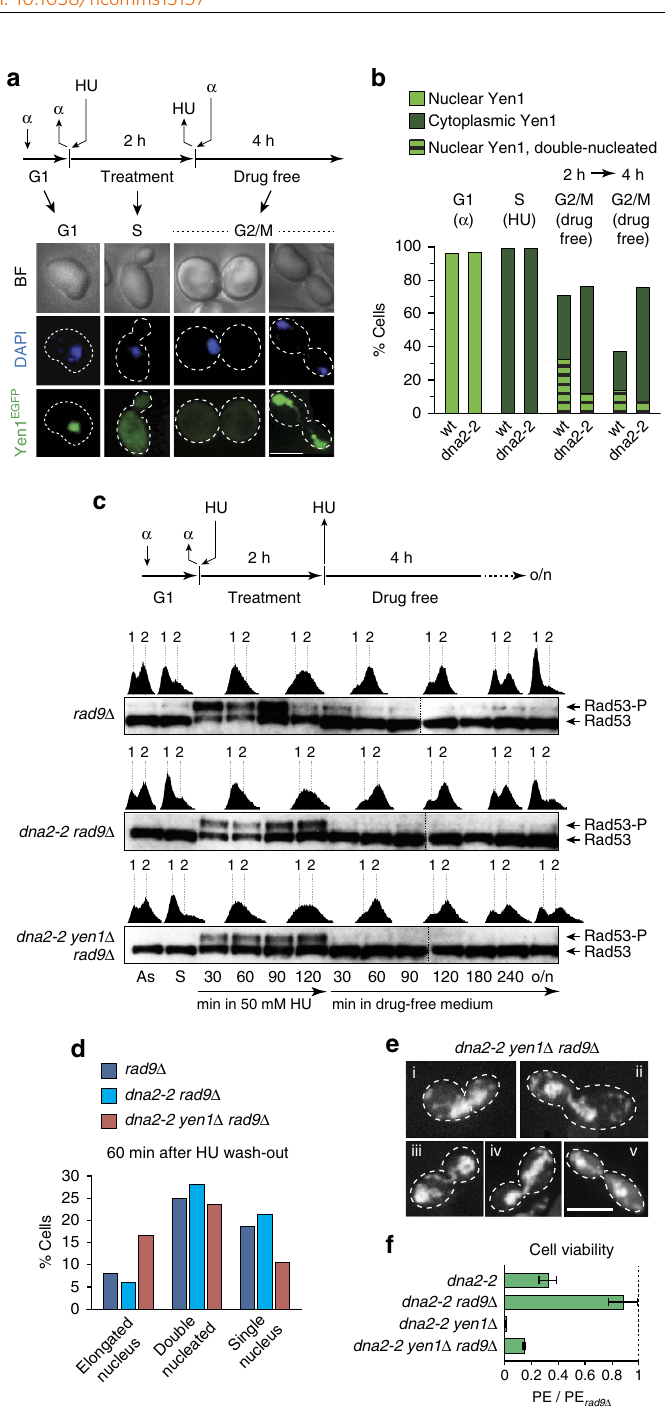
Figure 5 | Post-replicative chromosomal links in Dna2 helicase-defective cells and mitotic resolution by Yen1. ( a ) Subcellular localization of Yen1 in dna2-2 cells exposed to acute replication stress. Mitotic time-courses were performed as indicated with wild-type and dna2-2 cells expressing Yen1-EGFP. Samples were analysed for nuclear and cytoplasmic localization of Yen1-EGFP following a -factor arrest, 1h after release into HU-containing medium, and 2 and 4h after drug wash-out. Representative images are shown. Scale bar, 5 m m. ( b ) Quantitative view of Yen1-EGFP localization as determined in experiments such as those shown in a ( Z 100 cells scored for G1 and S phase per strain; Z 200 cells 2 and 4h after drug wash-out). ( c ) Mitotic time-course experiment with DNA damage checkpoint-disrupted strains, performed as indicated and analysed as described for Fig. 4a. ( d ) Relative distribution of cells in early anaphase (elongated nucleus), late anaphase (double-nucleated) and post-cytokinesis (single-nucleated), as determined by microscopic inspection of samples from c , 60min after HU wash-out ( Z 100 cells scored per strain). ( e ) Representative microscopic images showing an early anaphase cell with elongated nucleus spanning the bud neck (i), and late anaphase cells with chromosomal DNA bridges between the segregated masses of nuclear DNA (ii-v), a phenotype exclusively observed in dna2-2 yen1 D rad9 D cells. Cells treated as described for c . Scale bar, 5 m m. ( f ) Cell viability of the indicated strains, treated as in c , assessed by colony outgrowth. The mean plating efficiency (PE) ± s.e.m. ( n ¼ 3) is presented relative to rad9 D